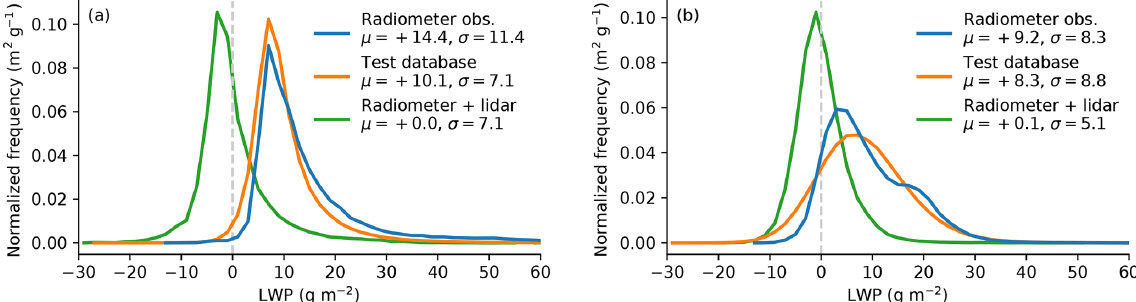
Figure 8. LWP distributions retrieved during clear-sky scenes only. Shown are the LWP retrieved with the neural network based on radiometer observations (blue lines) during (a) NARVAL1 and (b) NARVAL2, the retrieved LWP from the test database (orange lines) for profiles with LWP < 1gm − 2 , and the observed LWP after applying the lidar clear-sky correction (green lines). Mean ( µ ) and standard deviation ( σ ) are given for each distribution in grams per square meter (gm − 2 ).